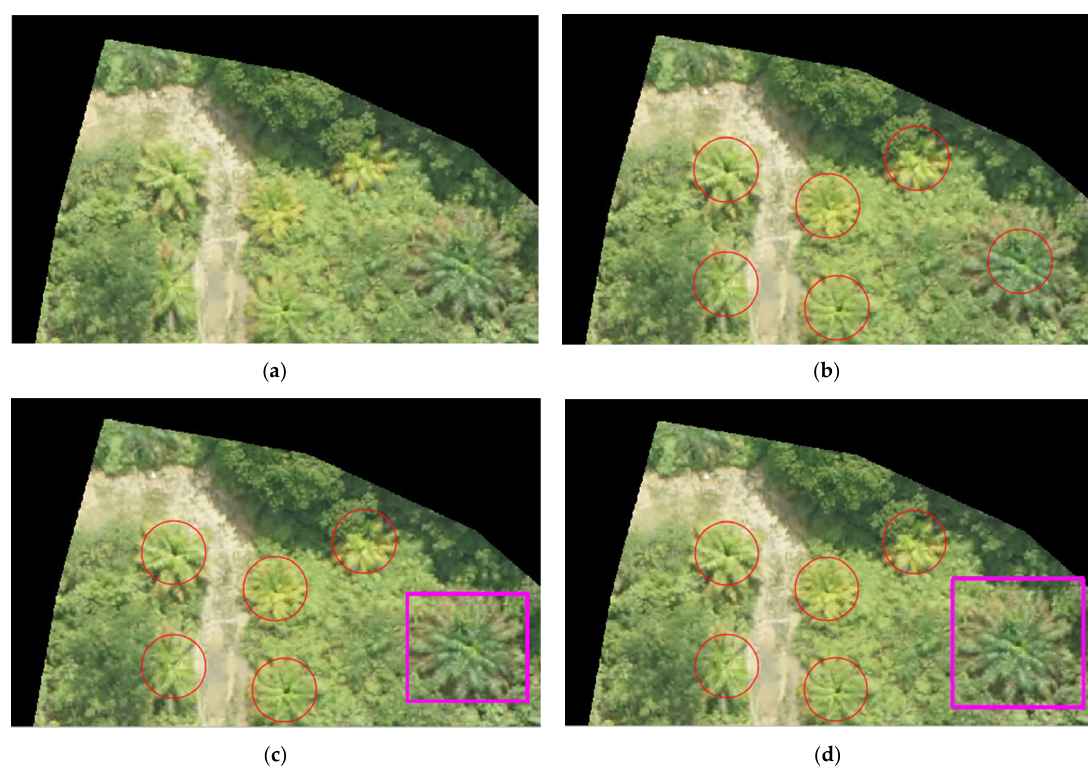
Figure 17. Oil palm trees with stressed growth: ( a ) Original image; ( b ) YOLOv3 detection; ( c ) YOLOv4 detection; ( d ) YOLOv5m detection.